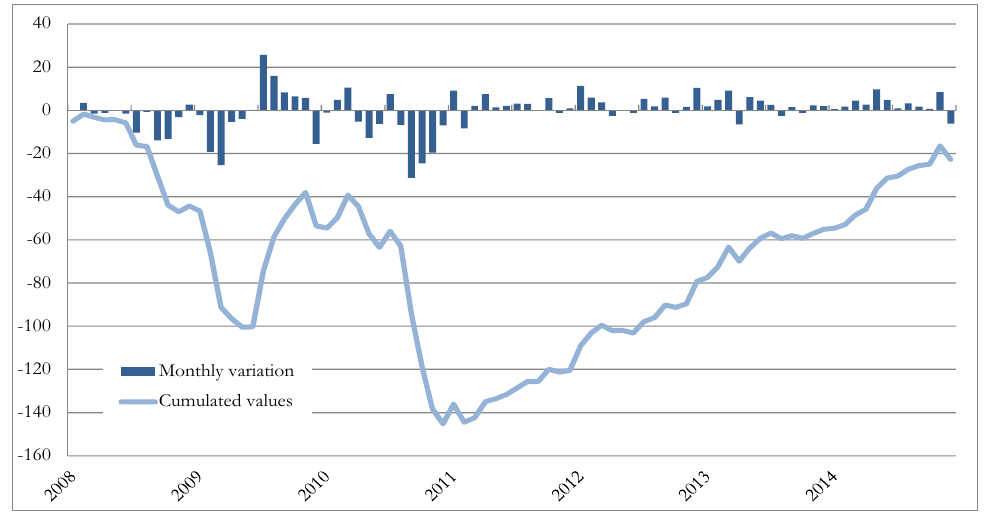
Figure 3. TARGET2 balances towards the Eurosystem, Ireland (Euro billion, monthly, end of the period). Source: Elaboration on the “Institute of Empirical